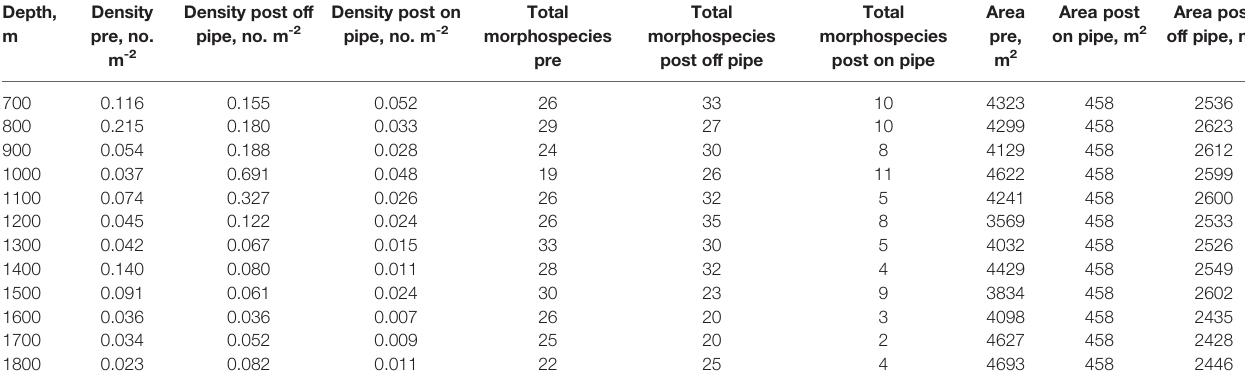
TABLE 2 | Depth-related patterns in density and morphospecies richness (number of morphospecies observed) both before (pre) and after (post) pipeline installation. Depth, Density m pre,